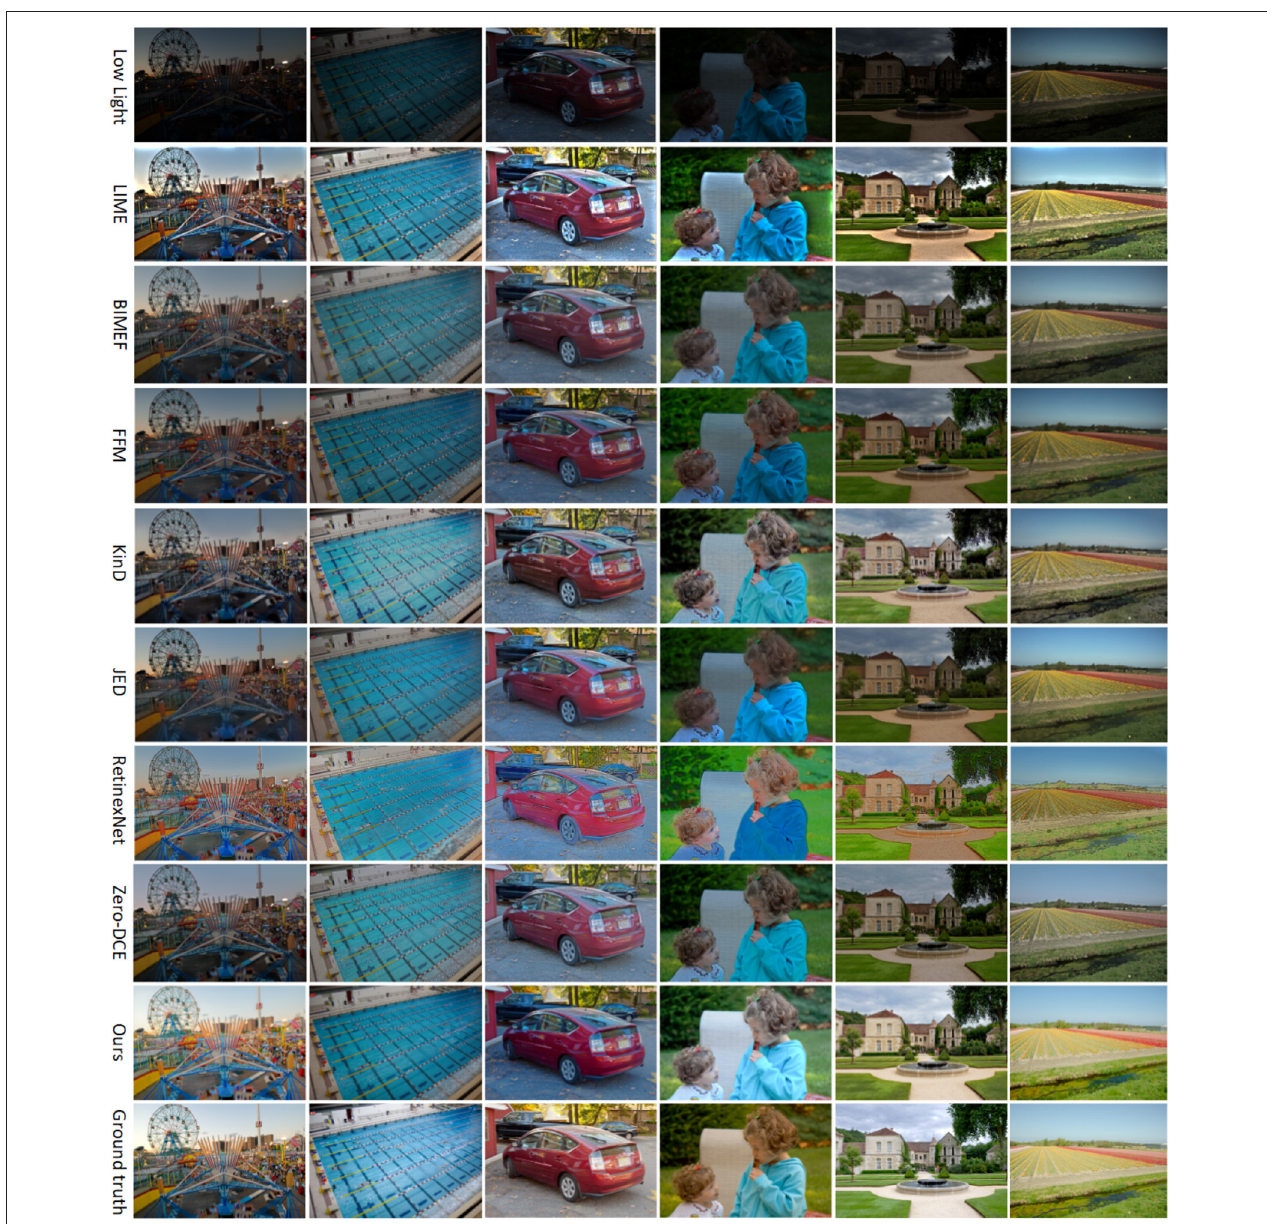
FIGURE 7 | Rows 2 to 8 in the figure show the enhancement effect of seven existing methods on low-light images, and the enhancement effect of the method in this article in the ninth